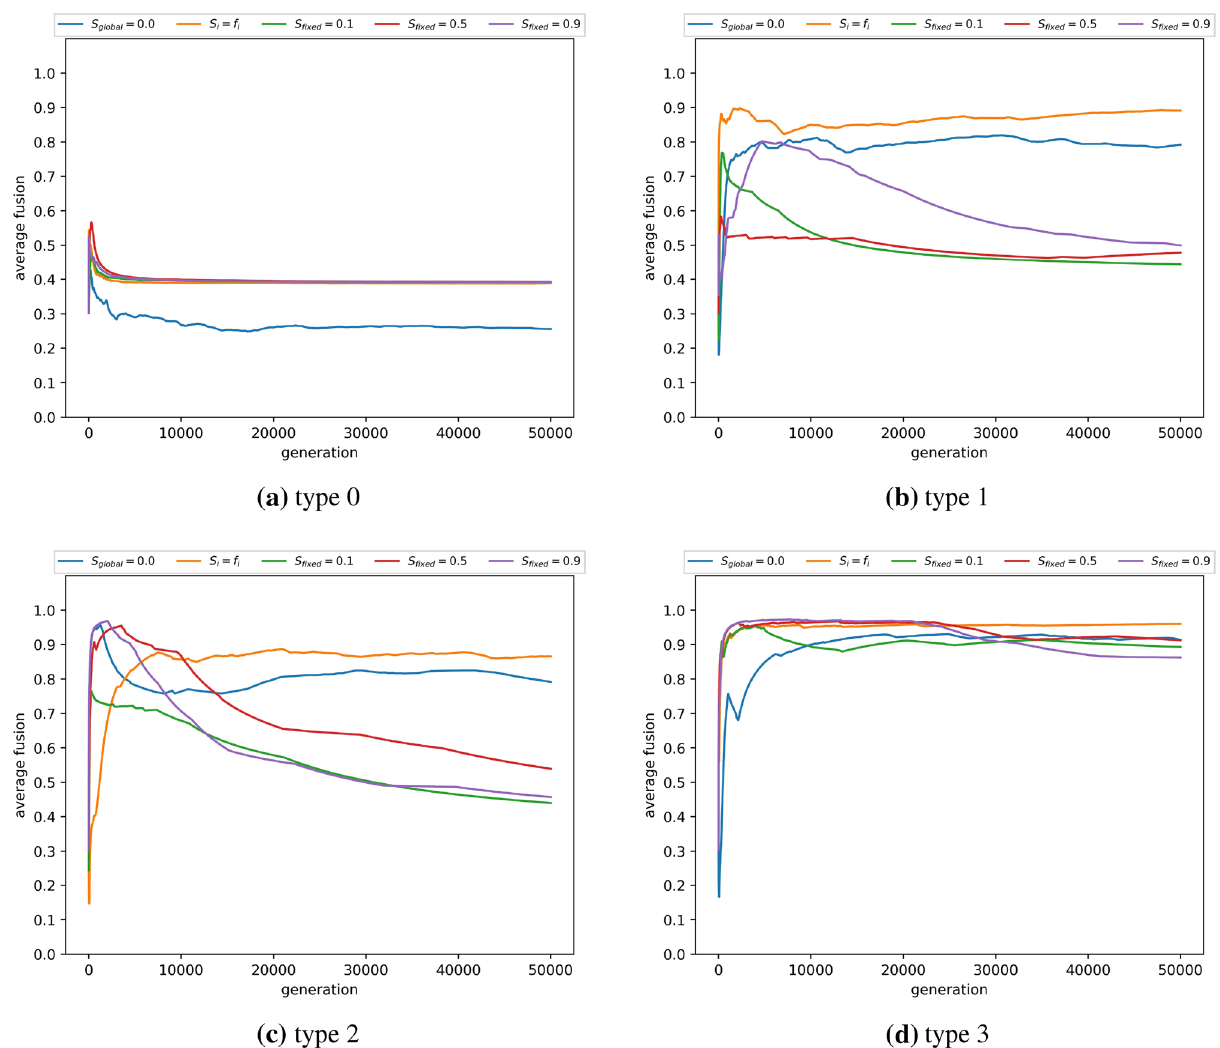
Figure 2. Average fusion per generation for type 1 ( b ), 2 ( c ) or 3 ( d ) ostracism. Type 0 ( a ) represents a scenario without ostracism. Ostracism is performed by each agent i with a probability equal to the agent’s fusion level f i . Average fusion is the sum of all occurrences of fusion levels seen up to and including the current generation, divided by the number of generation-agent pairs (the number of generation-agent pairs is the current generation number multiplied by the number of agents). Agents interact randomly with the other fused individuals within their in-group with fixed probabilities of S i ( S i = 0.1, 0.5, 0.9 ), or with a probability equal to their own current fusion level ( S i = f i ). S global indicates that all agents mix uniform randomly (i.e., S i = 0 ). The in-group of an agent i is defined as the subset of agents having at least same level of fusion as i (i.e., f i or greater). Agents interact randomly with the whole population with a probability equal to 1 − S i . Results are averaged over five randomly seeded runs. Parameter settings are consistent with Fig.